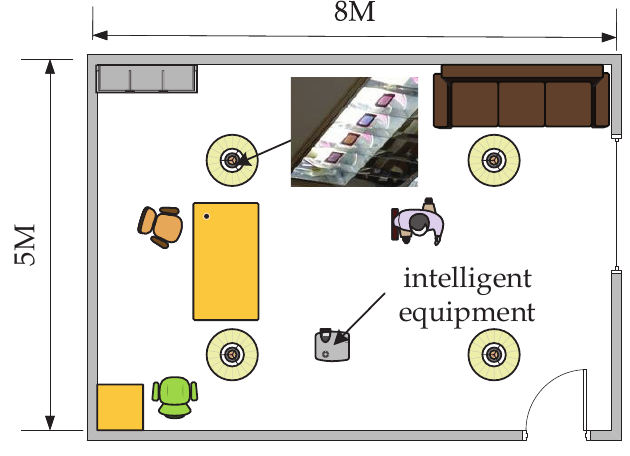
Figure 5. Illustration of